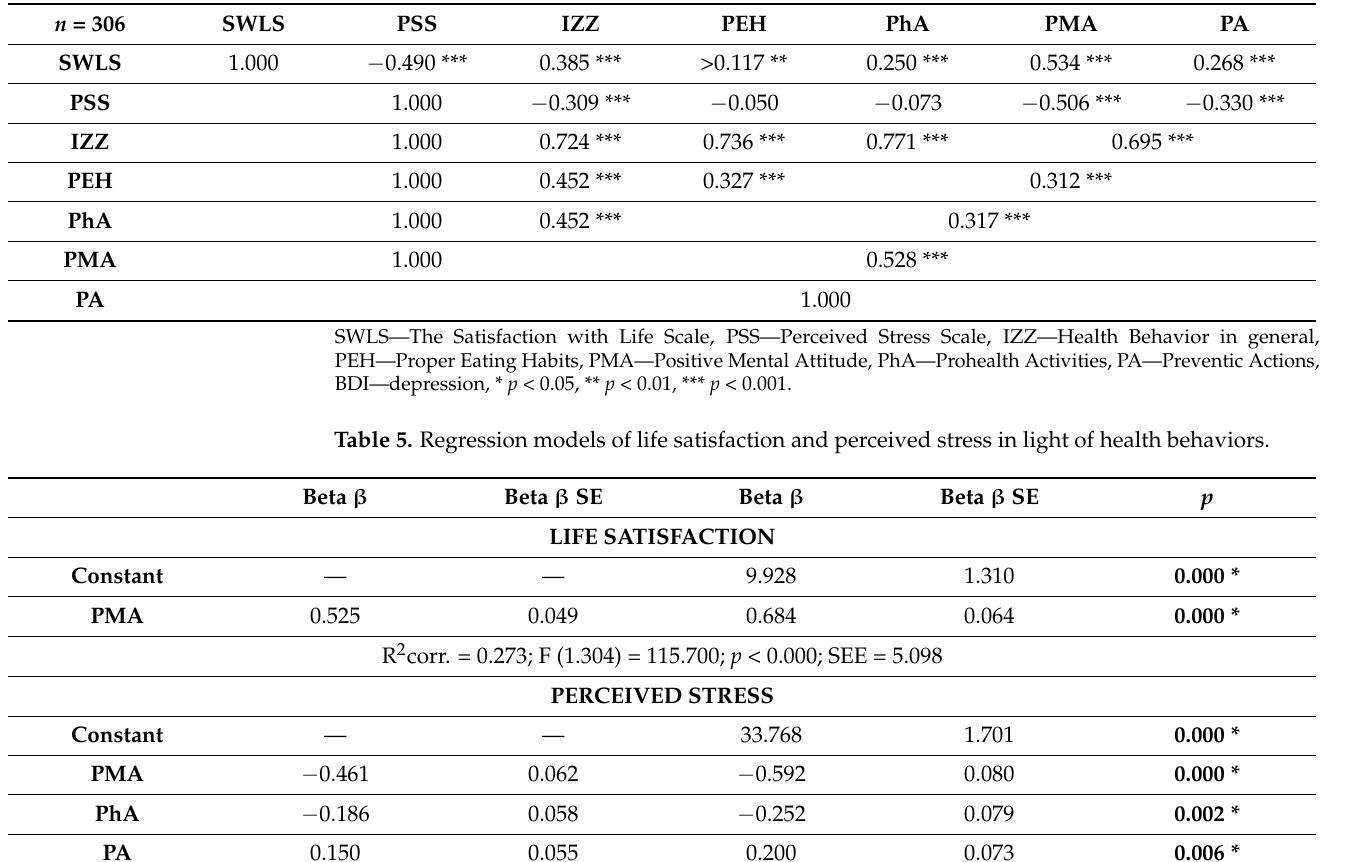
Table 4. Relationships between life satisfaction and perceived stress and health behaviors.